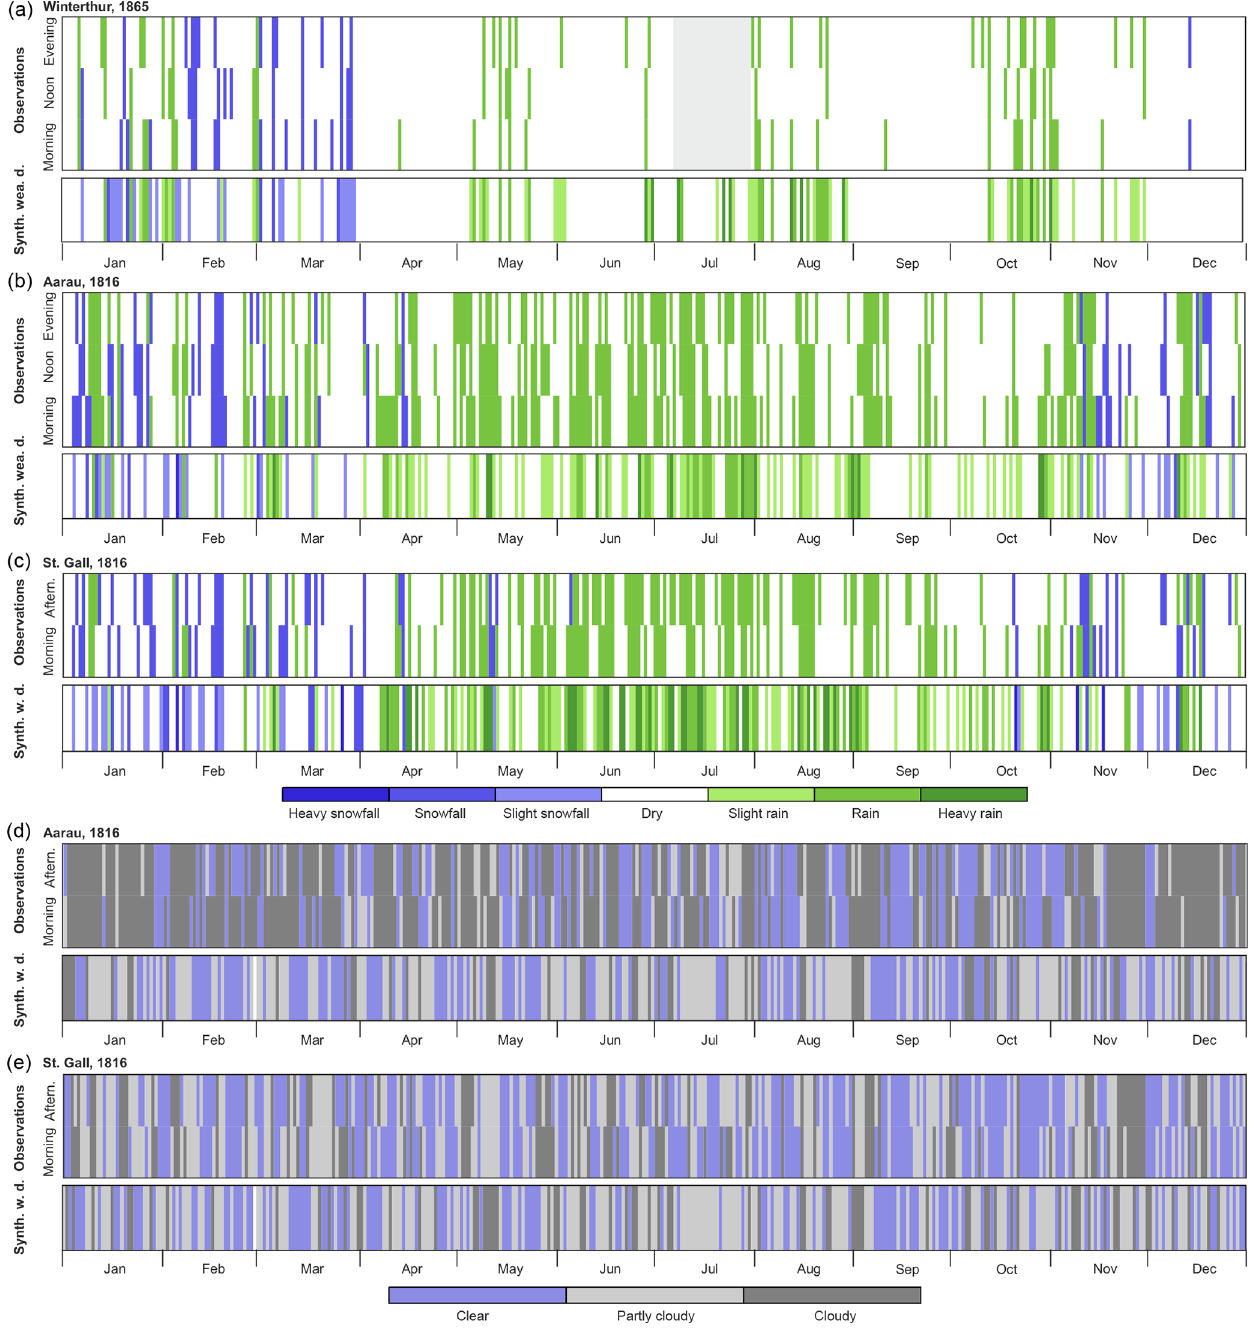
Figure 2. Comparison of observations (two–three times daily) and synthetic weather diaries (daily) for Winterthur (1865) ( a ) as well as Aarau ( b ) and St. Gall ( c ) (1816) for precipitation and for Aarau (d) and St. Gall (e) for sky cover. Grey shading in (a) indicates an observation